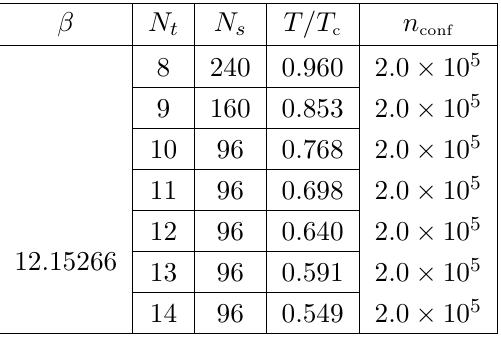
Table 5 . Information on the simulations at β = 12 . 15266 .